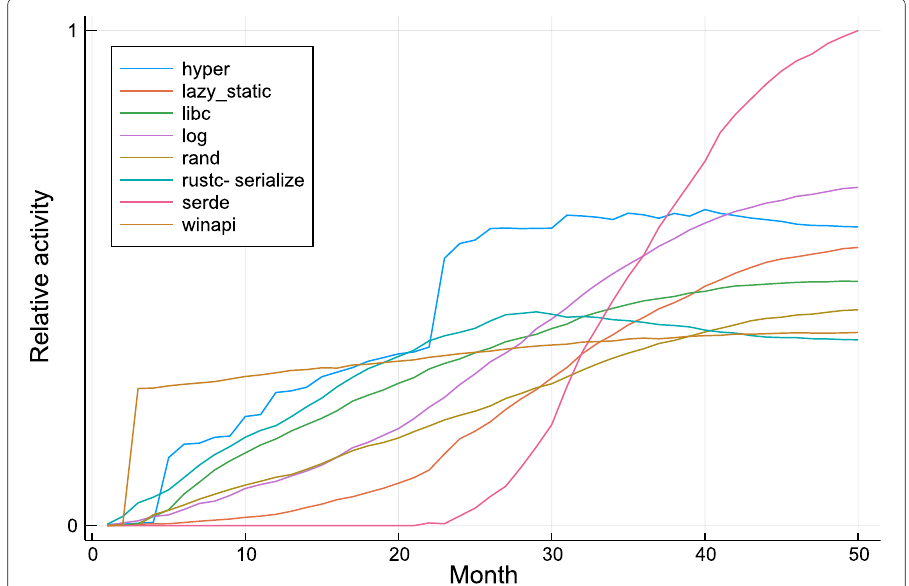
Fig. 16 CRAN community activity. Relative activity of each community in each month. The communities are named by important packages as detailed in the “Methods”